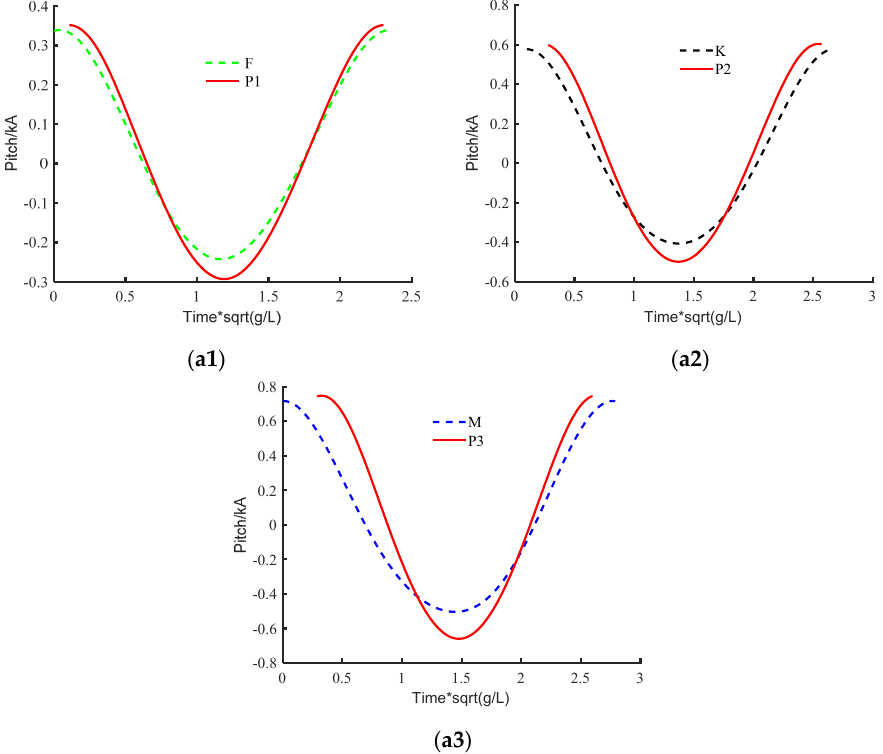
Figure 12. Effects of ship’s speed on rigid body motion response with different λ /L. ( a1 ) time series of pitch with λ /L = 0.857; ( a2 ) time series of pitch with λ /L = 1.07; ( a3 ) time series of pitch with λ /L=1.228;.